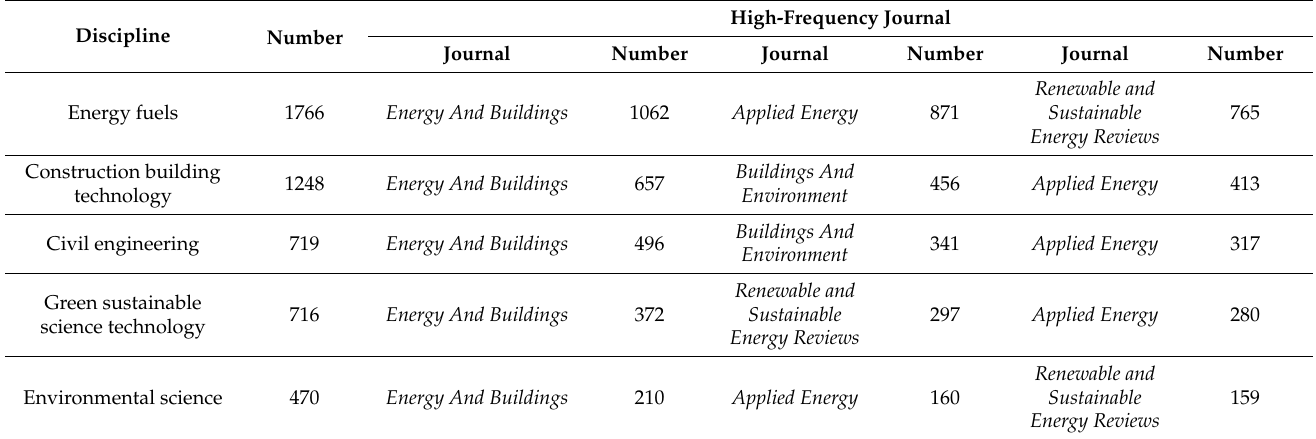
Table 6. High-yield subject classification and high-frequency journals.